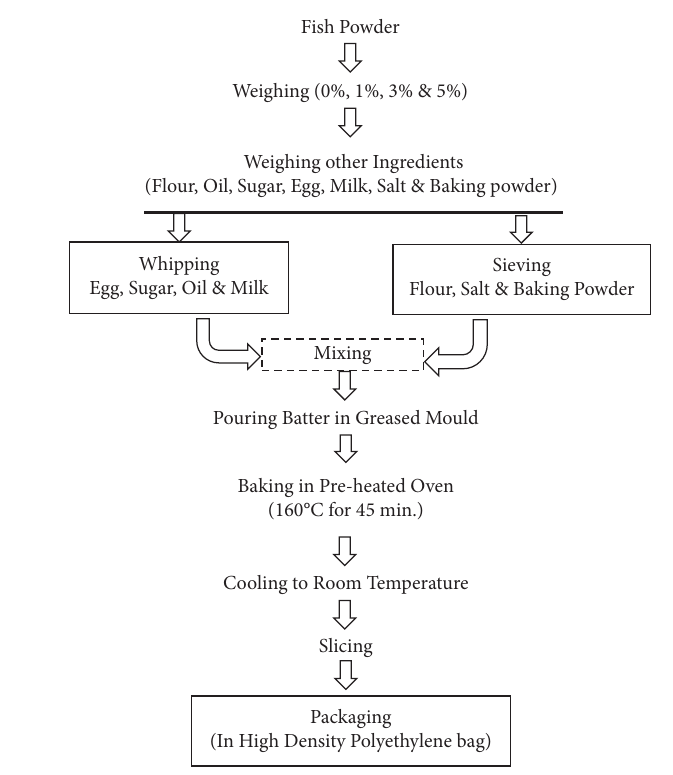
Figure 3: Processing fow chart of fortifed fsh cake. Table 2: Physical properties of Tilapia and Silver Carp fsh powder.